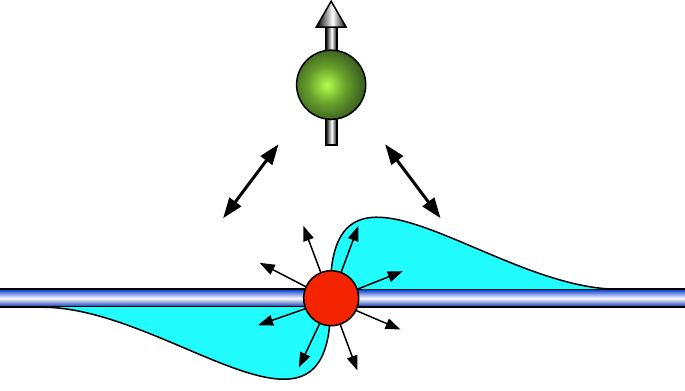
Figure 2: A spin-dependent interaction of a qubit (green) with a charged particle (cyan wave-function) in 1D and a monopole at the origin